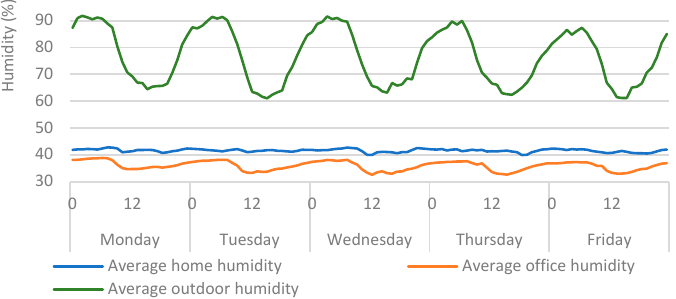
Figure 4. Average hourly humidity (per weekday) from each humidity source (home, office, and external). Qualitative findings are displayed alongside the quantitative data for context.